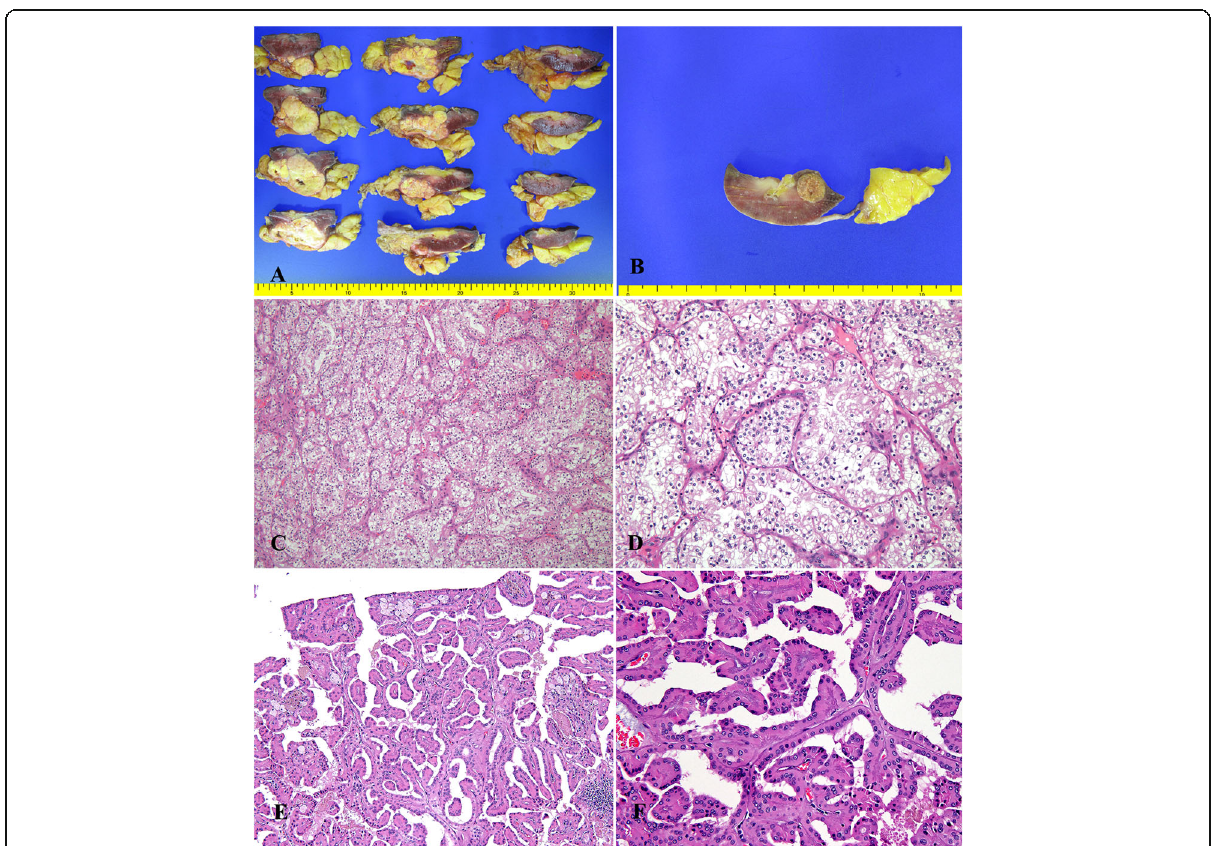
Fig. 1 The cut surface of the mass was bright golden yellow with areas of gray-white fibrosis and hemorrhage ( a ). A separate small nodule was present in the lower pole, measuring 1.2 × 1.0 × 0.6 cm ( b ). Microscopic findings of clear cell renal cell carcinoma ( c ). High-power view of clear cell renal cell carcinoma ( d ). Microscopic findings of papillary renal neoplasm with reverse polarity (PRNRP) ( e ). High-power view of PRNRP ( f